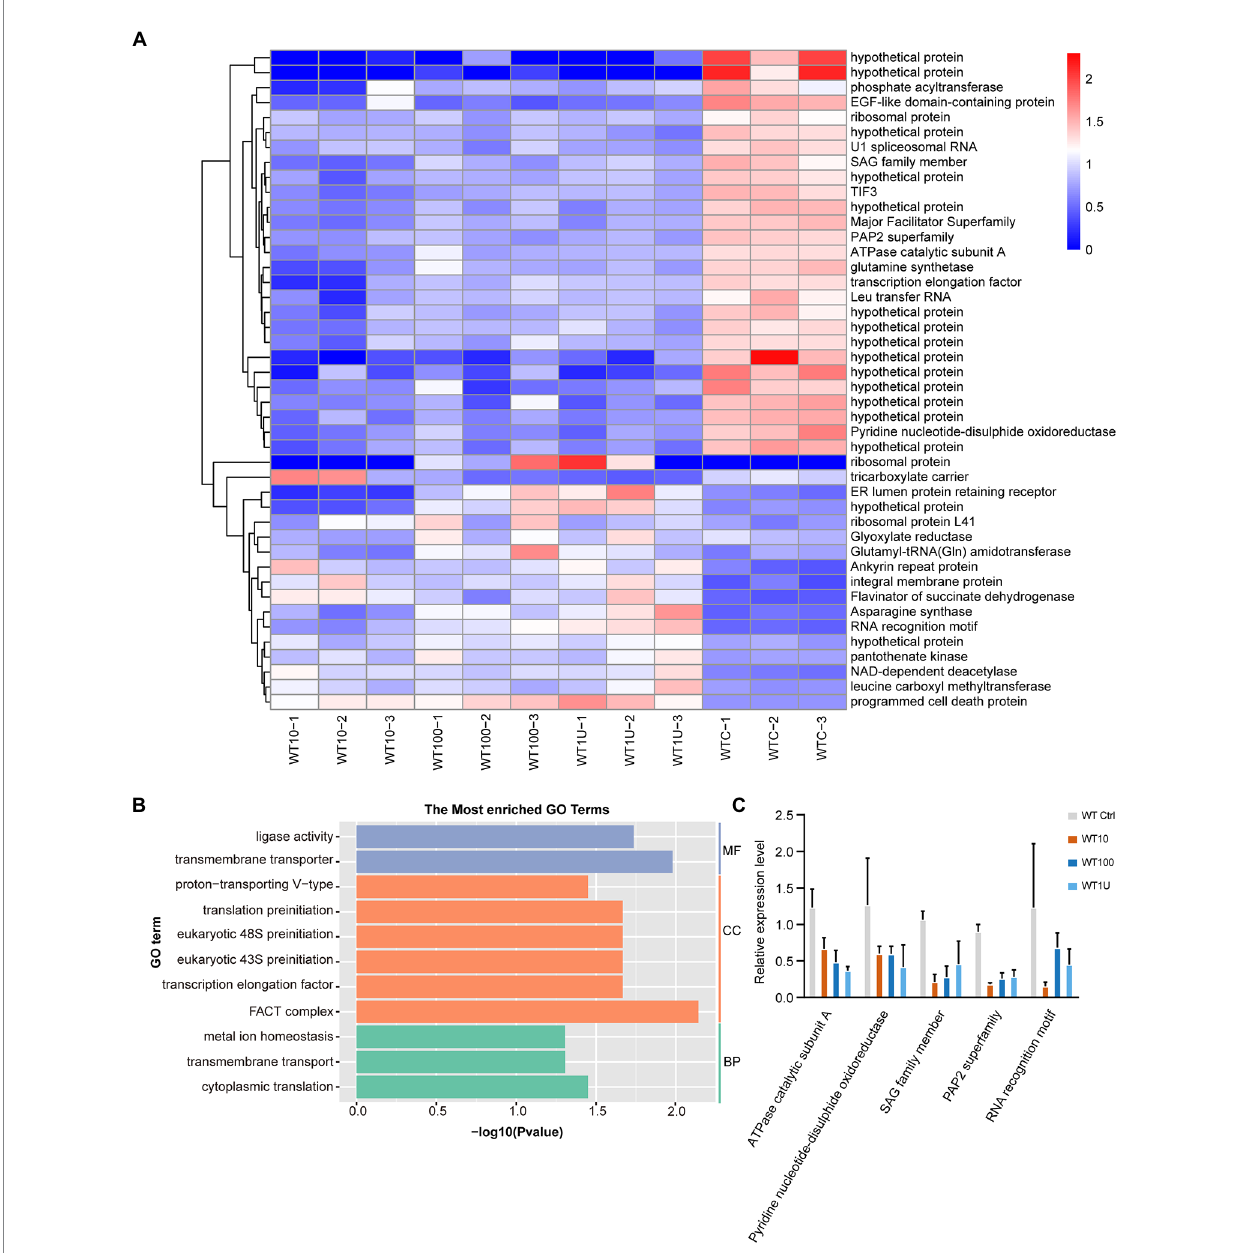
FIGURE 3 Differential expression of genes shared among sensitive strains after halofuginone treatment (A) Heat map of the log 2 fold change of significantly different genes among three treatment groups. Each treatment consisted of three biological replicates (B) Functional enrichment of shared DEGs among sensitive groups with different concentrations of halofuginone. The 11 most extensive GO terms of the three GO categories “molecular function” (blue), “cellular component” (orange), and “biological process” (green) are shown. (C) Verification of gene expression by real-time quantitative PCR. The black bars with standard errors indicate fold changes based on the relative expression level determined by qPCR using the 2 −ΔΔ CT method for three biological